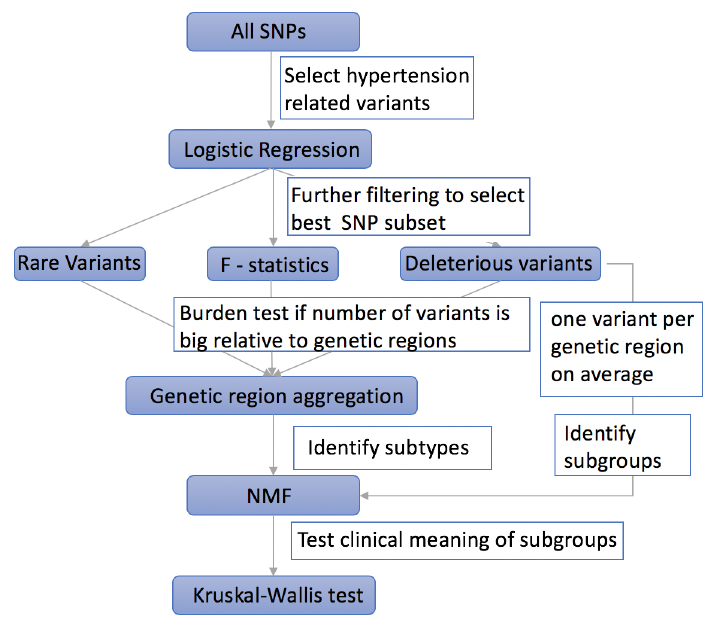
Figure 1. Flow chart of the procedure to select informative variants and identify hypertension